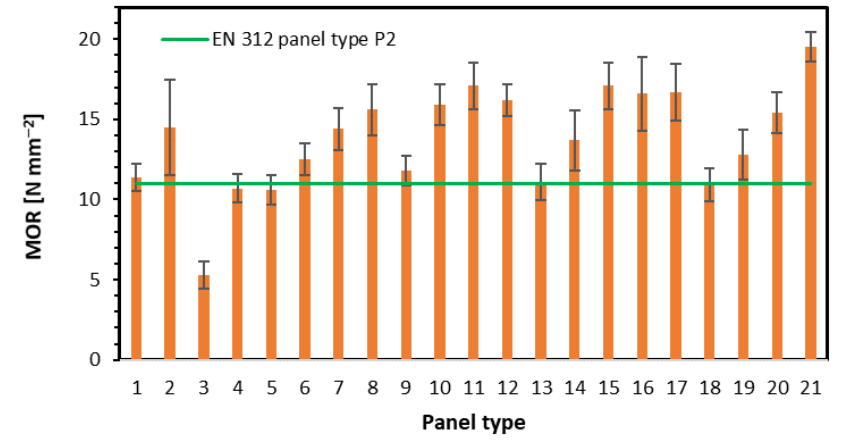
Figure 3. The modulus of rupture of tested panels.